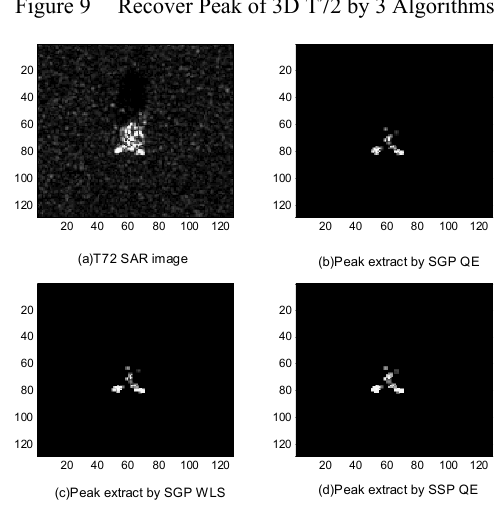
algorithm and Synthetic Sinc Model based on QE algorithm are compared with the T72 original SAR image in Figure 9.